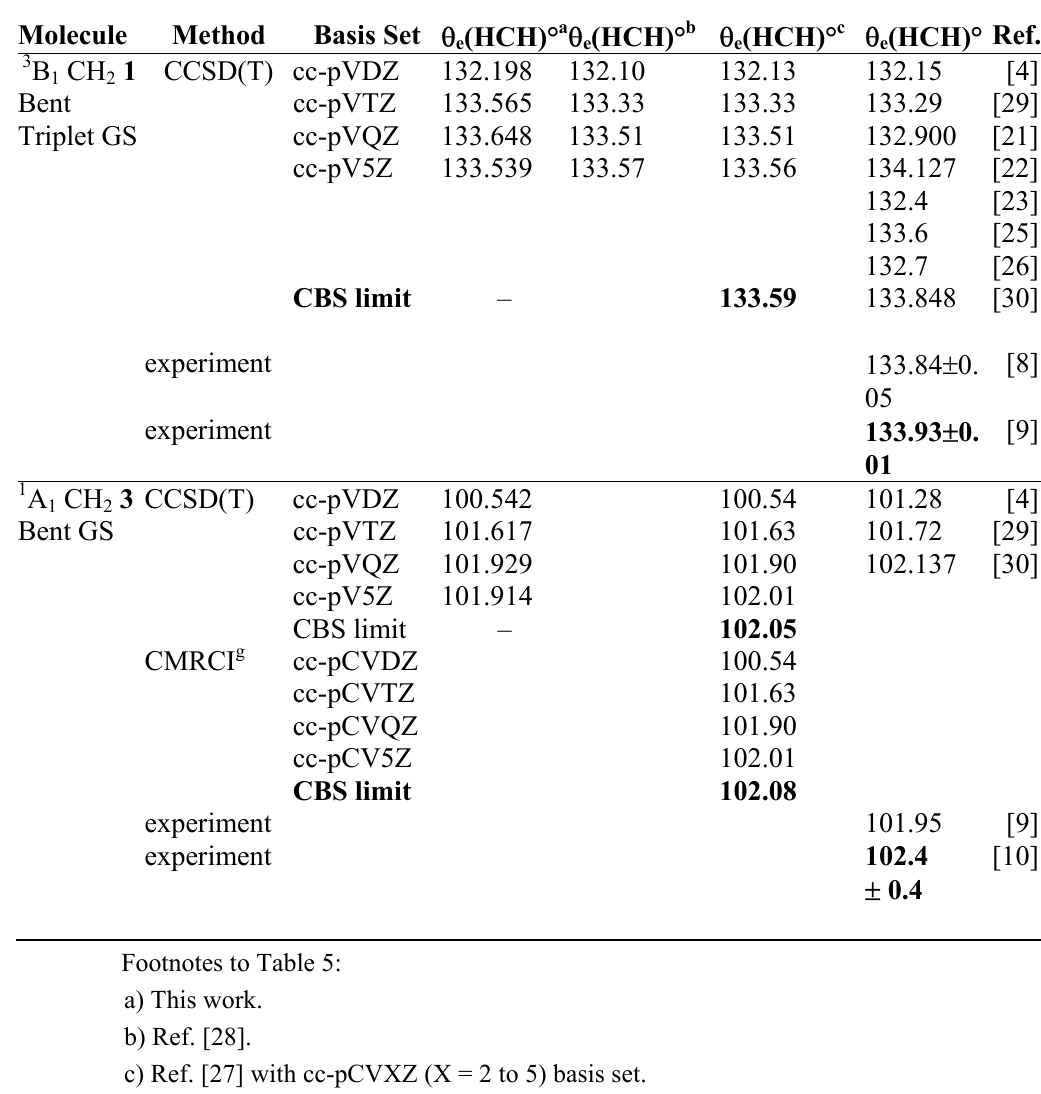
Table 5. Calculated CCSD(T) and other equilibrium bond angles θ methylenes 1 and 3 in comparison to experimental and literature